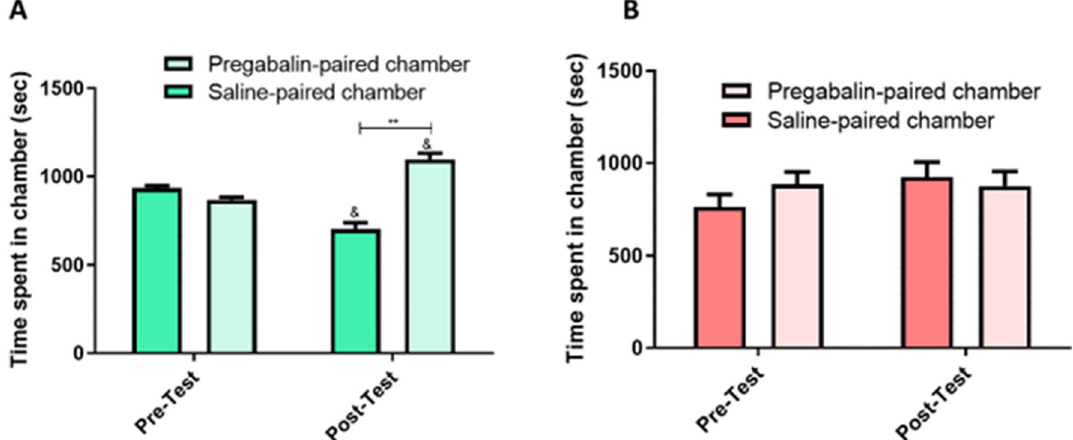
Figure 3. Time spent in the conditioning chambers during the pre and postconditioning tests in the saline- pregabalin ( A ) and SKF-pregabalin ( B ) groups. ( A ) The mice spent significantly more time in the pregabalin- paired chamber during the postconditioning test compared to the preconditioning test. Moreover, there was a significant increase in the time spent in the pregabalin-paired chamber during the postconditioning test compared to that spent in the saline-paired chamber (n = 6). Values are reported as means ± standard error of the mean. ( B ) There was no significant change in the time spent in the conditioning chambers during the pre and postconditioning tests in the SKF-pregabalin group (n = 7). Values are reported as means ± standard error of the mean (** p < 0.01, & p < 0.05 compared to the preconditioning